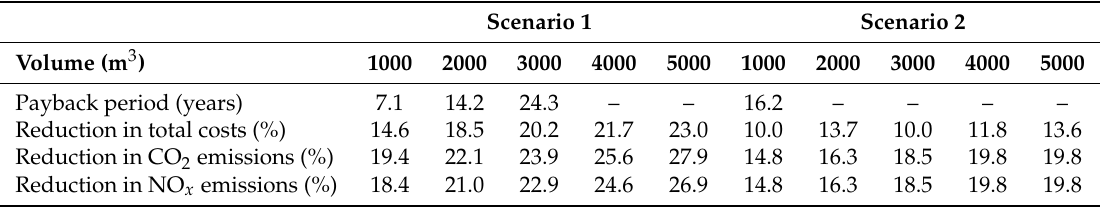
Table 3. Payback period, and the relative reduction in total peak heating costs and CO 2 /NO x emissions for all scenarios and tank